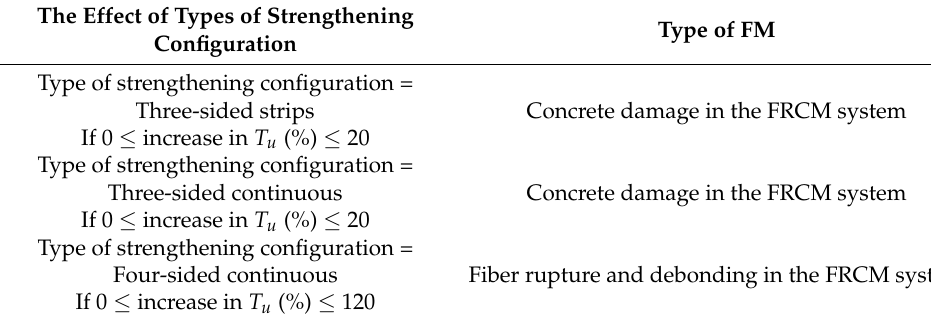
Table 11. An increase in torsional strength T u for various strengthening